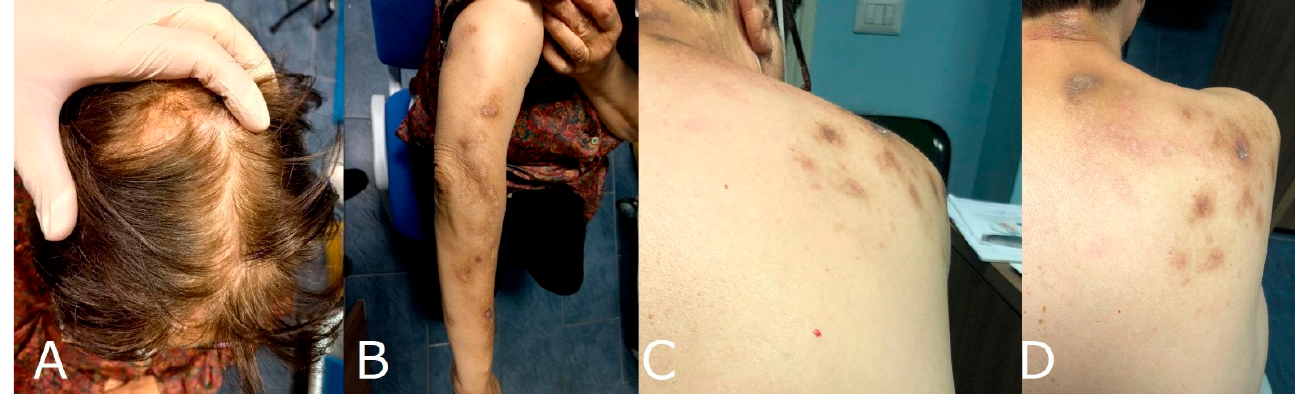
Figure 2. Multiple hyperkeratotic nodules on the right side of the head ( A ), the right upper limb ( B ), and the right upper trunk ( C , D ) before dupilumab treatment.